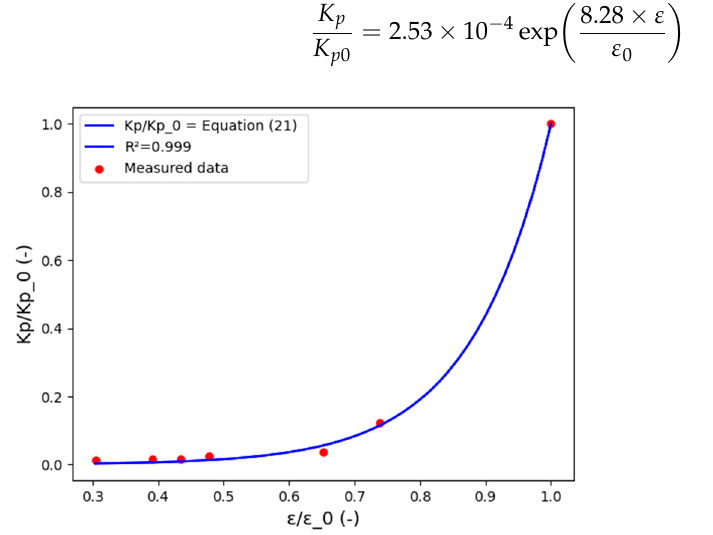
Figure 11. Variation of the measured permeability with the compressed MCC PH101 powder tablet porosity.